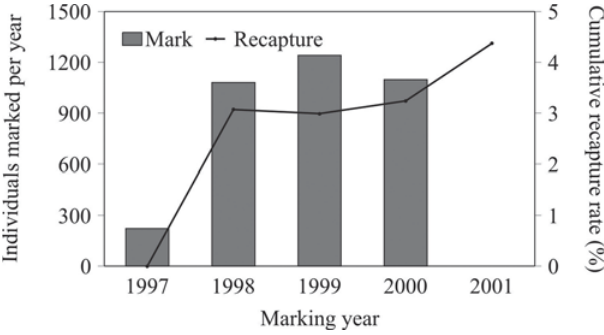
Fig. 1 . Total number of fish specimens marked per year and cumulative recovery rates in rio Paraopeba, from 1997 to